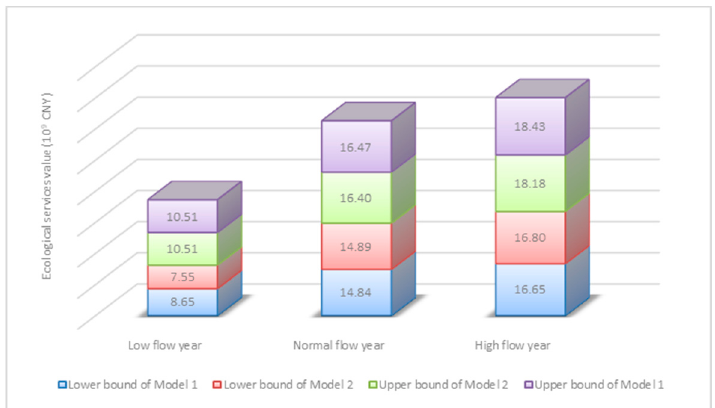
Figure 7. The comparison of the IDCP and IFDCP models from the perspective of the total ecological service value.